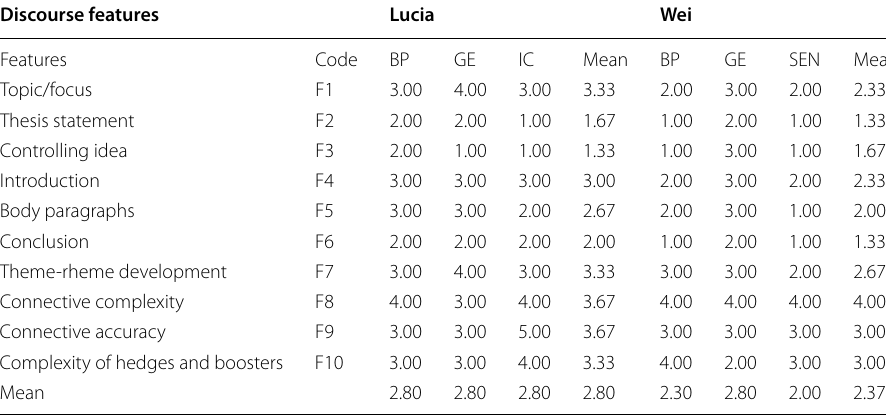
Table 1 Results from essay coding Discourse features Lucia Features